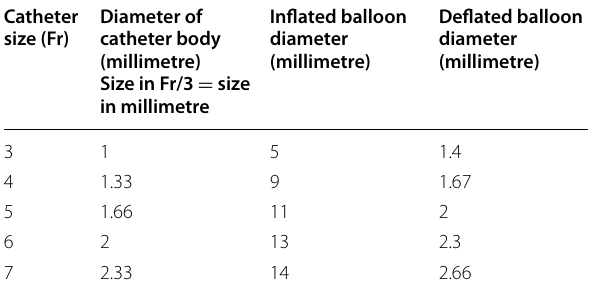
Table 2 Dimension of Fogarty EC along with the dimension of its balloon in deflated and inflated state Catheter Diameter of size (Fr) catheter